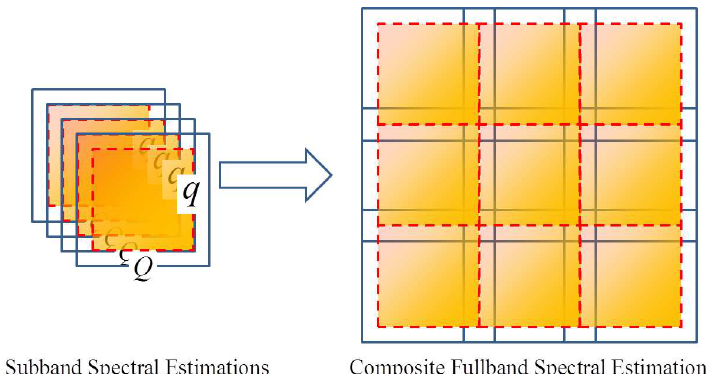
Figure 6. Illustration of mosaicking the sub-band spectral estimations into a composite spectrum. The sub-band spectral estimations are overlapped, while the composite full-band spectrum is without overlap (the boxes with solid lines cover the spectral estimation of the sub-bands; the boxes with dashed lines cover the valid spectral